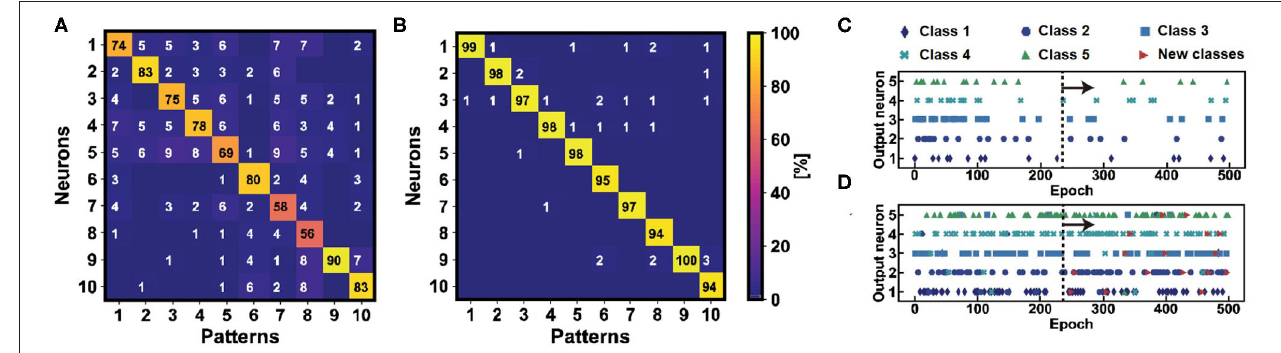
FIGURE 5 | Confusion matrices for the study of the average accuracy of the learning activities for the 10 classes of the Fashion-MNIST training dataset without (A) and with (B) homeostasis. The learning accuracy highlights a high and stable tendency only when homeostatic neurons are used as post-synaptic neurons in the WTA network, reaching a value of 97%. (C) Fire activities of 5 homeostatic and non-homeostatic (D) neurons in 500 epochs of pattern and noise presentations. The homeostatic neurons are robust against “false” patterns presentations from another dataset, e.g., MNIST (here submitted after the 250 th